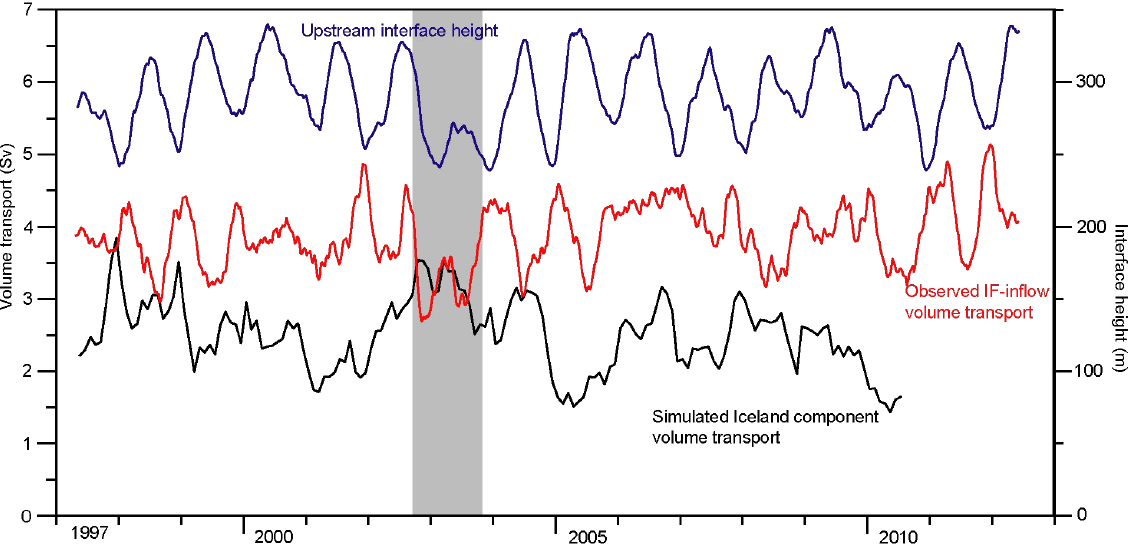
Figure 11. Twelve-week running mean observed IF-inflow (red, left scale) and reconstructed upstream interface height (blue, right scale) and 3-month running mean of the Icelandic component of the simulated IF-inflow (black, left scale). The grey box highlights the